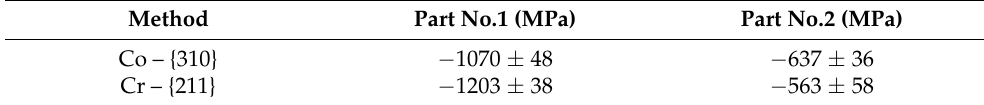
Table 7. Values of macroscopic residual stresses σ ± ∆ σ